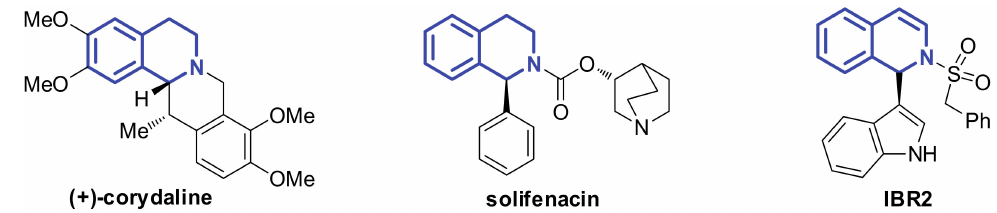
Figure 1. Biologically Active